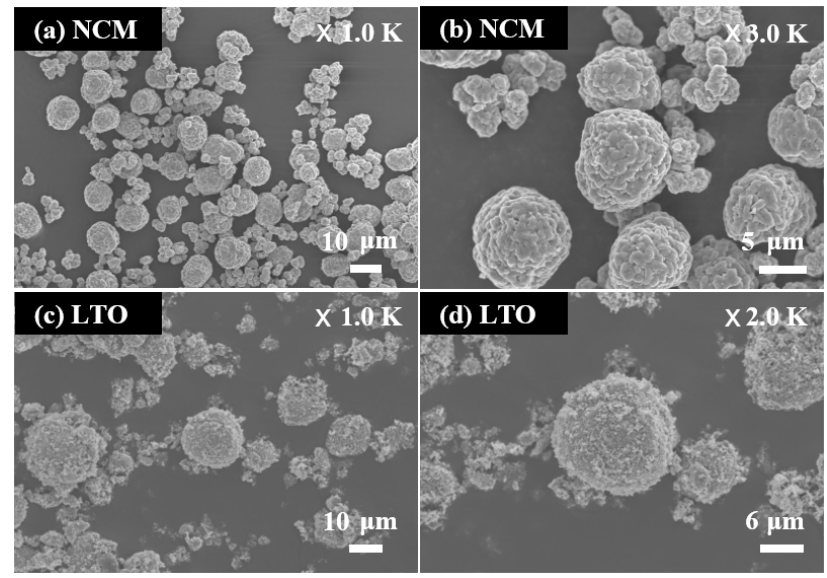
Figure 1. FE-SEM images of ( a , b ) NCM powder and ( c , d ) LTO powder. Figure 2a,b, respectively, depict the XRD patterns of the NCM and LTO powders. As shown in Figure 2, the XRD patterns of NCM and LTO powder were identified and in-